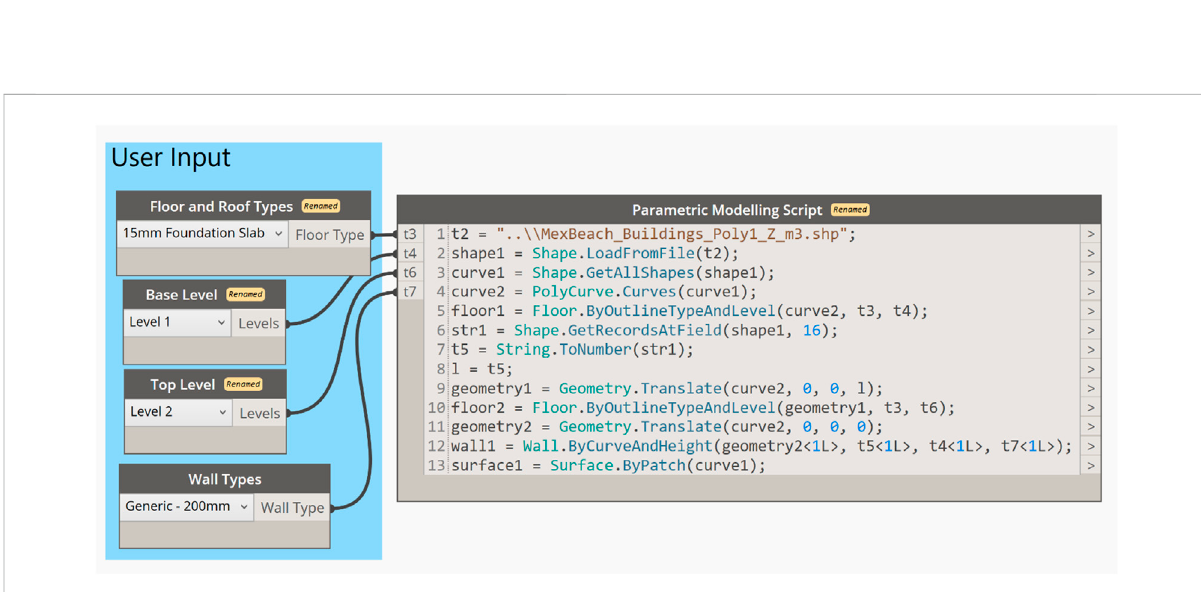
Frontiers in Built